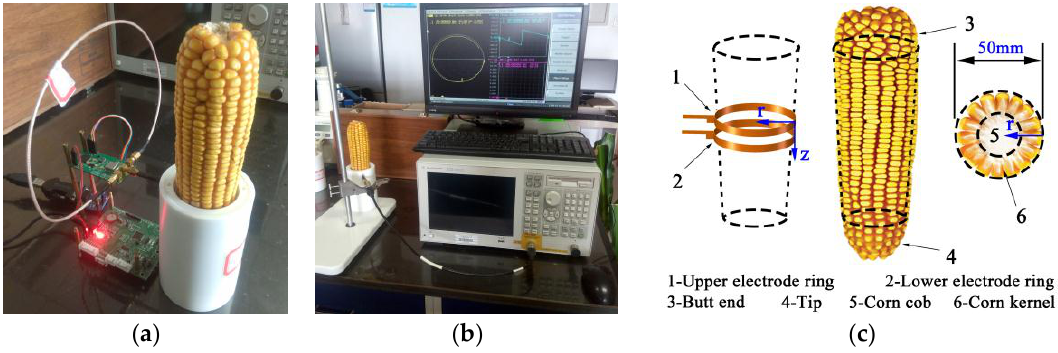
Figure 1. Experimental setup for in situ measurement of corn kernels in a corn ear. ( a ) The device prototype with the sensor; a high-frequency detection circuit is connected to the measurement electrodes of the sensor; ( b ) a VNA is connected to the measurement electrode, where the electrode’s output impedance values ( R and X ) are shown on the computer screen; and ( c ) the appearance of corn ear.